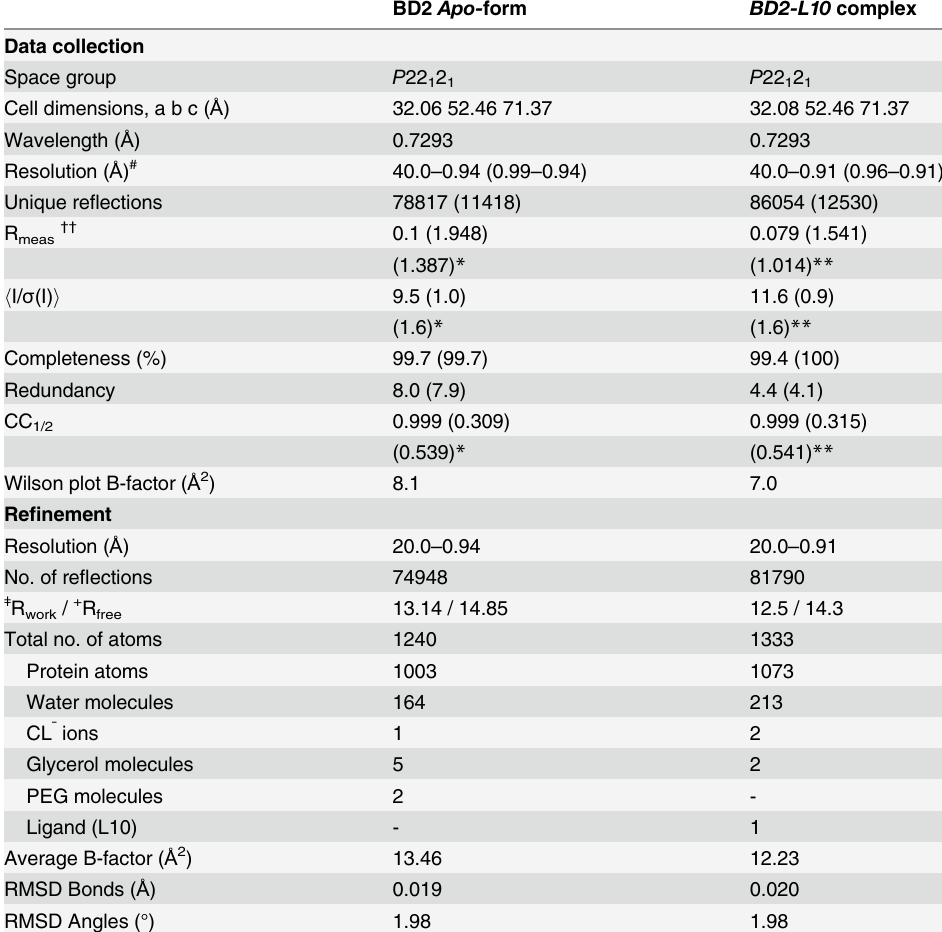
Table 1. Data reduction and refinement statistics of the apo- form of BRD2-BD2 and BD2-L10